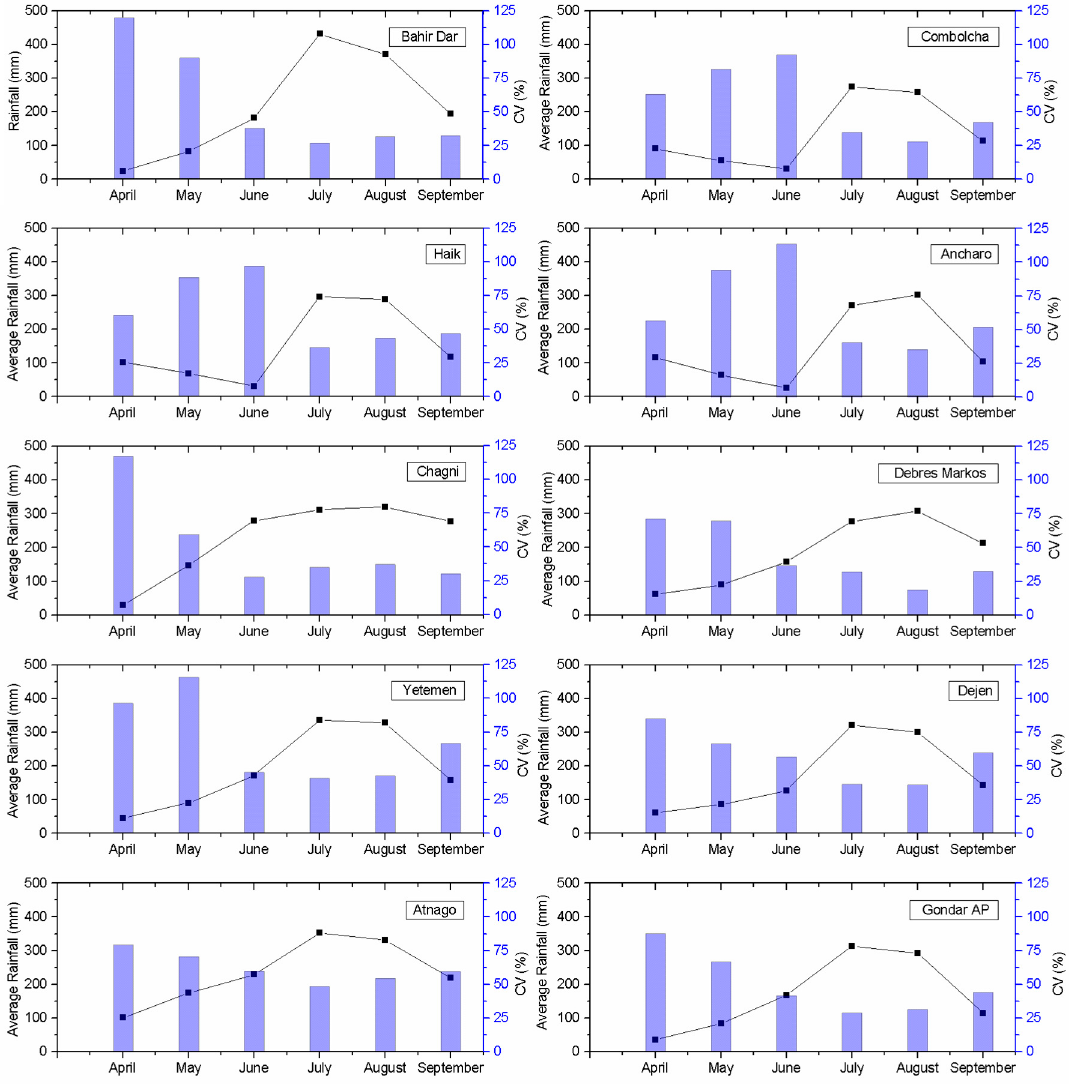
Figure 4. Amount of rainfall in the summer season contributed by each month (lines) and the coefficient of variation of rainfall in each month (bars).